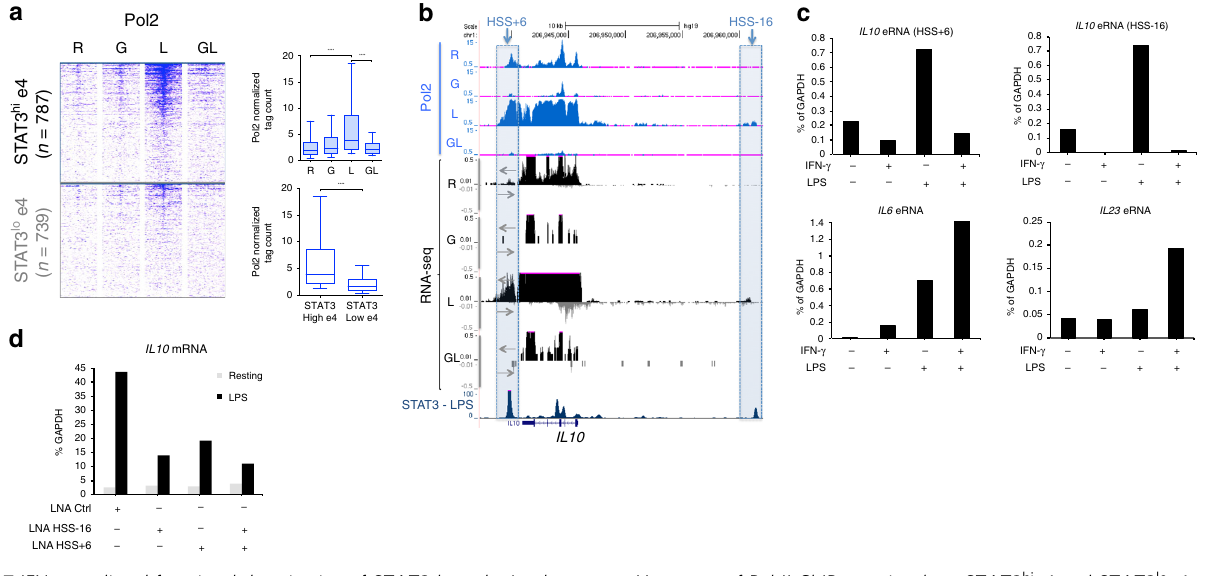
Fig. 7 IFN- γ -mediated functional deactivation of STAT3-bound e4 enhancers. a Heatmaps of Pol II ChIP-seq signals at STAT3 hi e4 and STAT3 lo e4 enhancers (de fi ned in Fig. 6a). The boxplots indicate normalized tag counts at STAT3 hi e4 enhancers in the four indicated conditions (top) and at STAT3 hi e4 and STAT3 lo e4 enhancers in LPS-stimulated macrophages (bottom). **** p < 0.0001, paired-samples Wilcoxon signed-rank test. Boxes encompass the twenty- fi fth to seventy- fi fth percentile changes. Whiskers extend to the tenth and ninetieth percentiles. The central horizontal bar indicates the median. b Representative Genome Browser tracks showing RNA polymerase II (Pol II) occupancy, strand-speci fi c RNA transcripts, and STAT3 occupancy (LPS condition) at enhancers of IL10 . Boxes enclose HSS + 6 (left) and HSS-16 (right). c RT-qPCR analysis of enhancer RNA (eRNA) expression at two e4 enhancers (top, IL10 -HSS + 6 and IL-10 -HSS-16) and two e5 enhancers (bottom, IL6 and IL23A ). Data are representative of three independent experiments. d RT – qPCR analysis of IL10 mRNA in resting and LPS-stimulated macrophages transfected with the indicated LNAs ( IL10 -HSS-16 eRNA and and IL10 -HSS + 6 eRNA). Data are representative of two independent